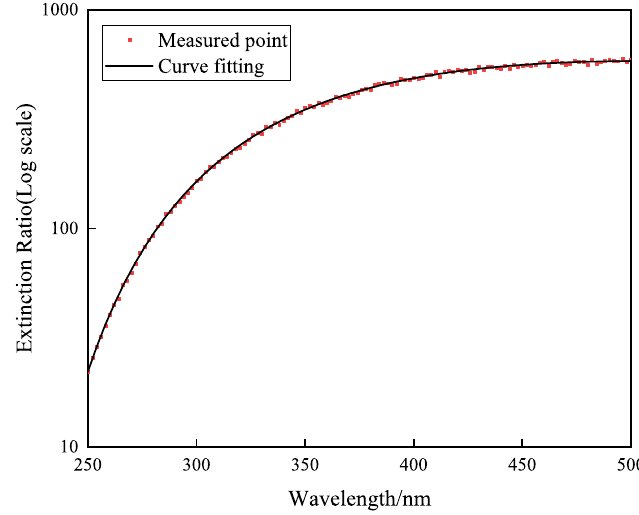
Figure 16. Curve of extinction ratio with respect to wavelength.